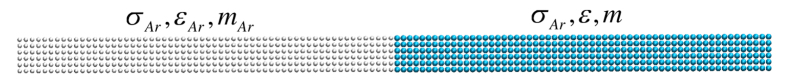
Schematic of our model structure: the interface of two LJ solids.Different interfaces will be formed by keeping the left side of the interface constant and equal to solid argon (indicated by subscript Ar) and modifying  and  on the right side of the interface.